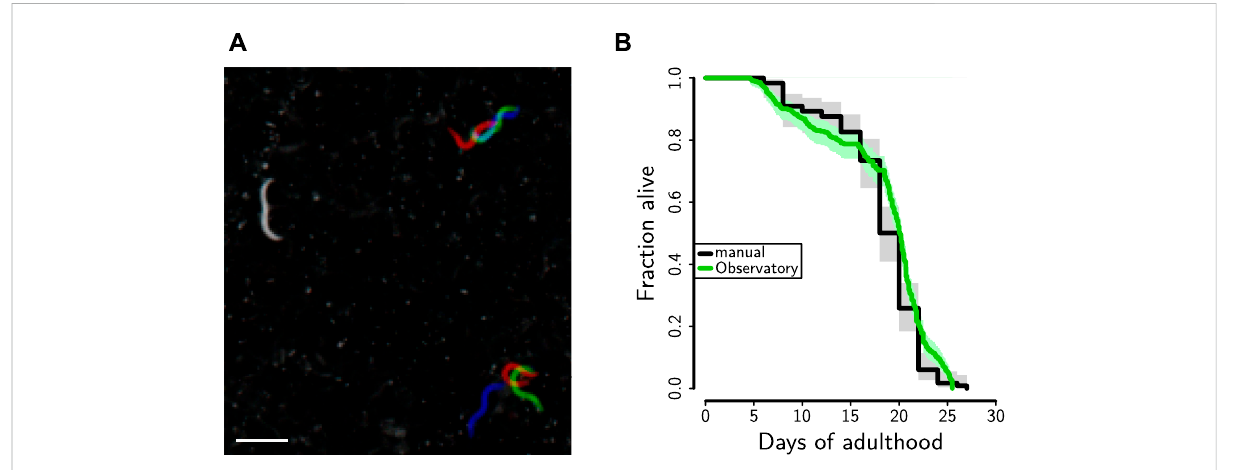
FIGURE 8 Lifespan determination. (A) Snapshots saved during successive recording sessions (6 h apart) were overlaid in red, green, and blue. This allows rapid visual identi fi cation of animals who are dead (gray; left), are moving their whole bodies (red, green, and blue; lower right), or are moving part of their bodies (part gray, part color; upper right). Scale bar is 1 mm. (B) Lifespan of CF512 on RNAi control bacteria either in the Observatory (green, median lifespan 20.1 days, n = 343 deaths) or in a 25 ° C incubator (black, median lifespan 20.0 days, n = 119